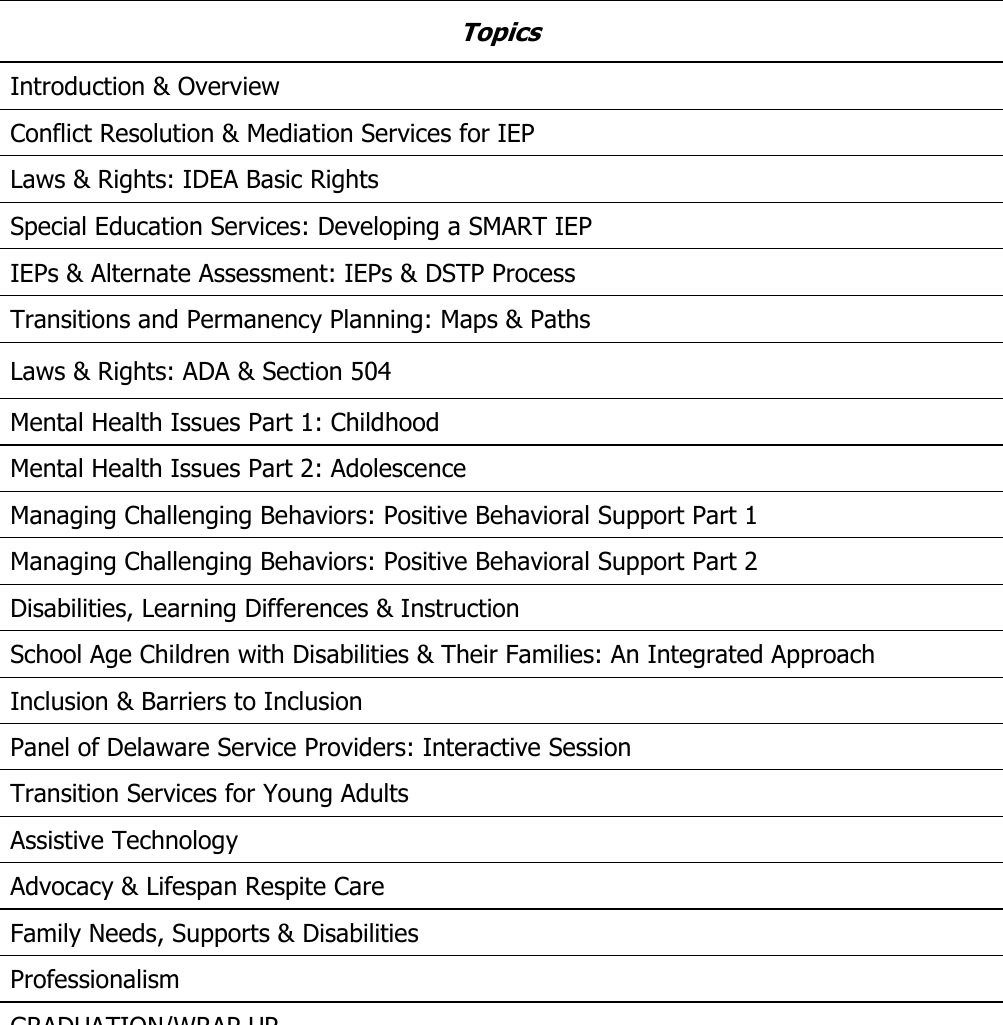
Disability Specialist training topics